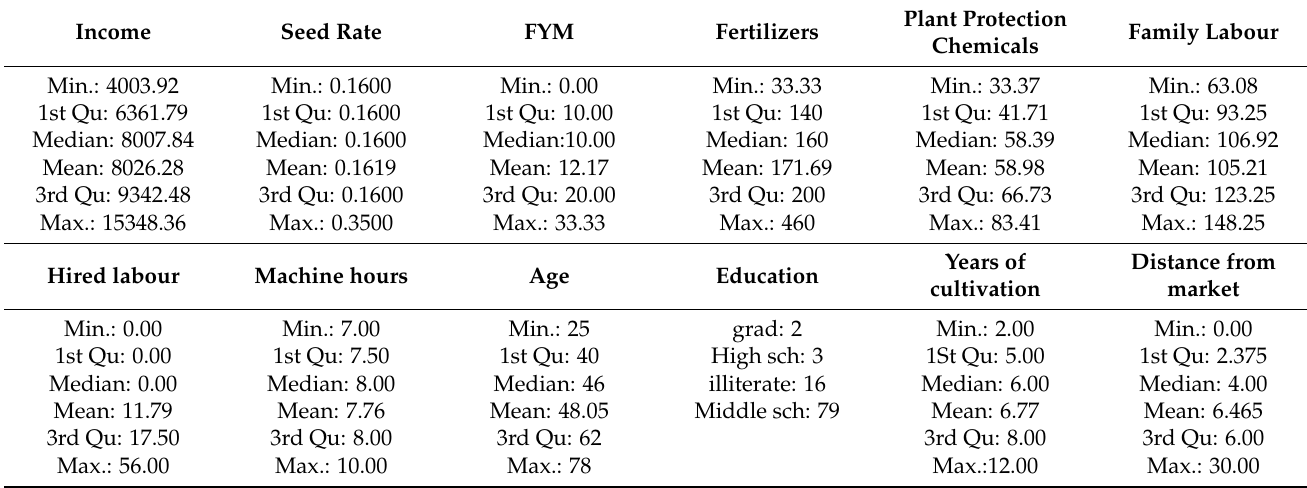
Table 13. Descriptive statistics on the variables used in the tobit model.